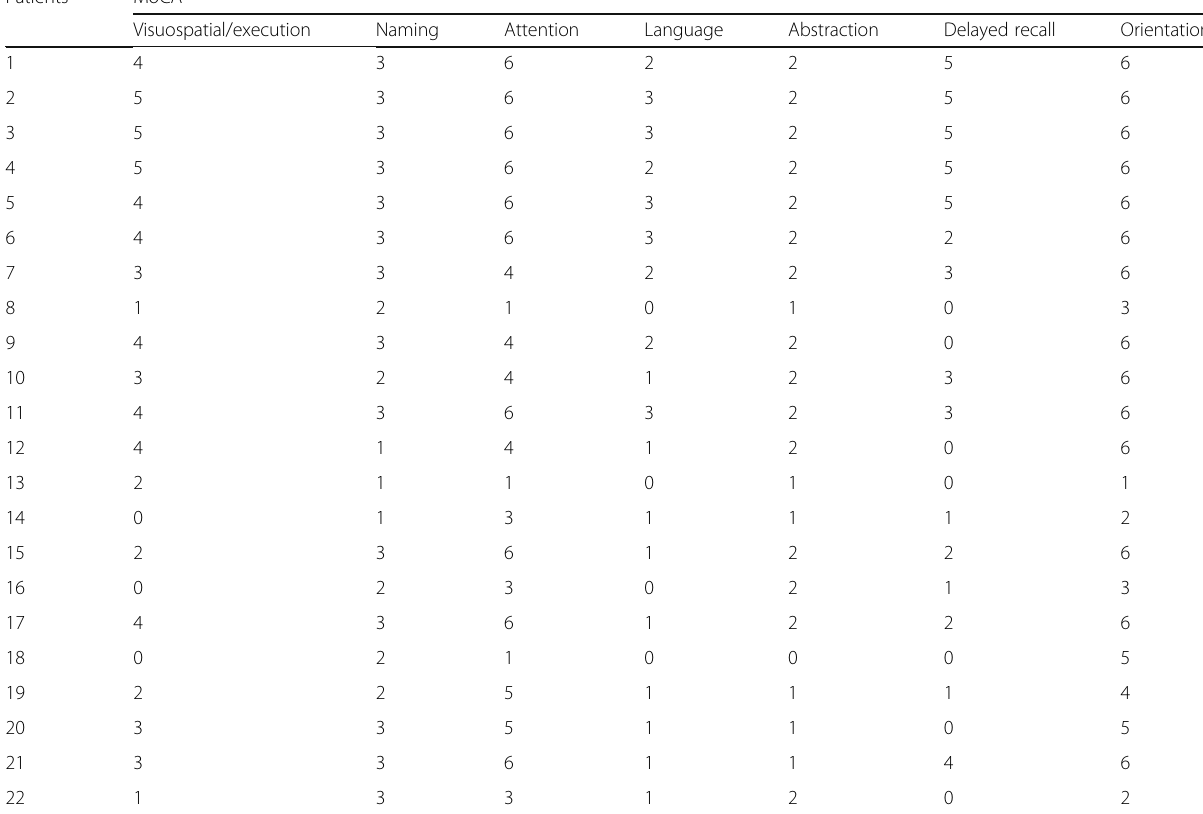
Table 2 The different subscores of MoCA in CADASIL patients Patients